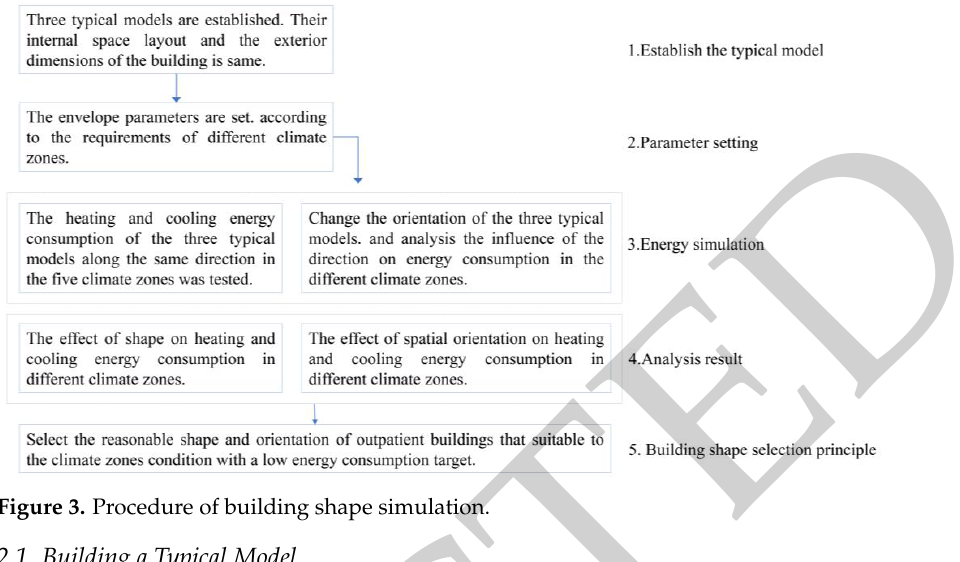
Figure 3. Procedure of building shape simulation.